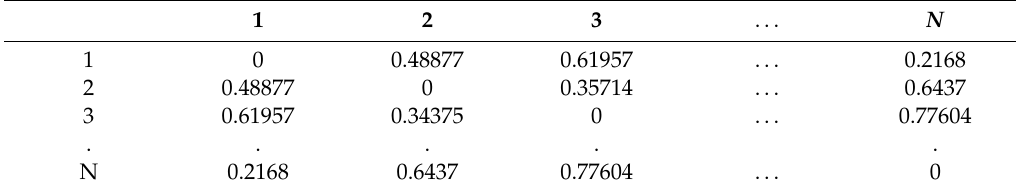
Table 2. Distance matrices between all the